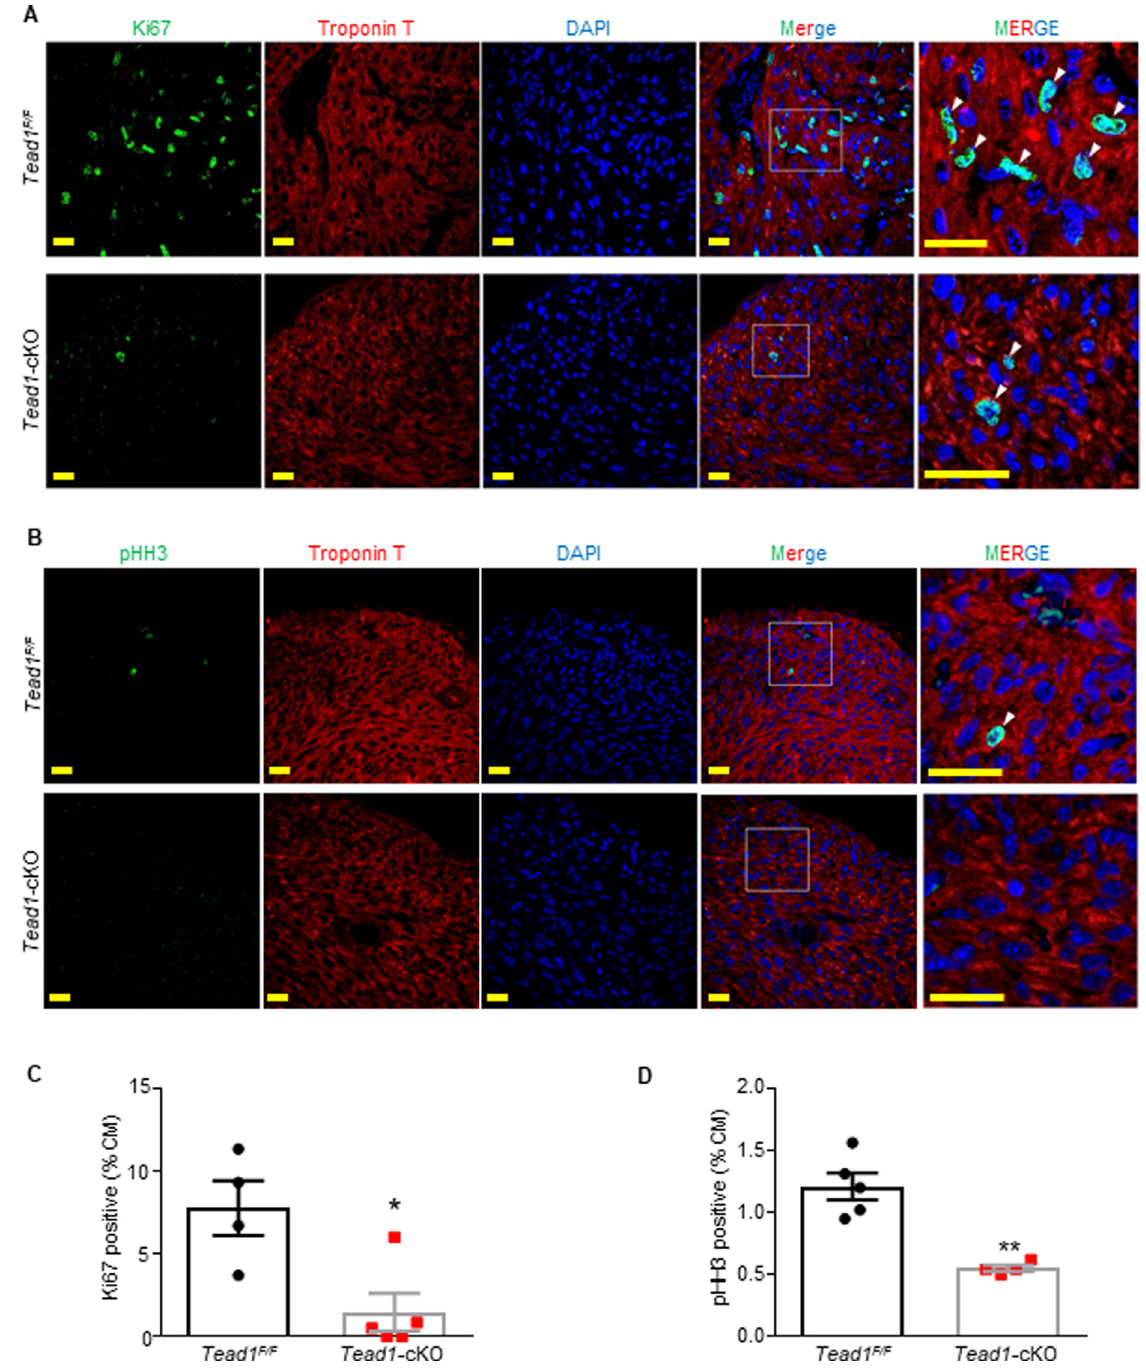
Fig 5. Tead1 is required for cardiomyocyte proliferation. ( A, B ) Cardiomyocyte proliferation (Ki67) and mitosis (phospho-Histone 3 Ser10 positive immunostaining) in postnatal day 1 Tead F/F and Tead1 -cKO hearts. ( C, D ) Quantitative analysis represents counting of multiple sections from three independent samples per group (approximately 1.2–1.5 X 10 5 cardiomyocytes were counted). �� p < 0.01; Student’s t -test. Scale bar, 20 μ m.